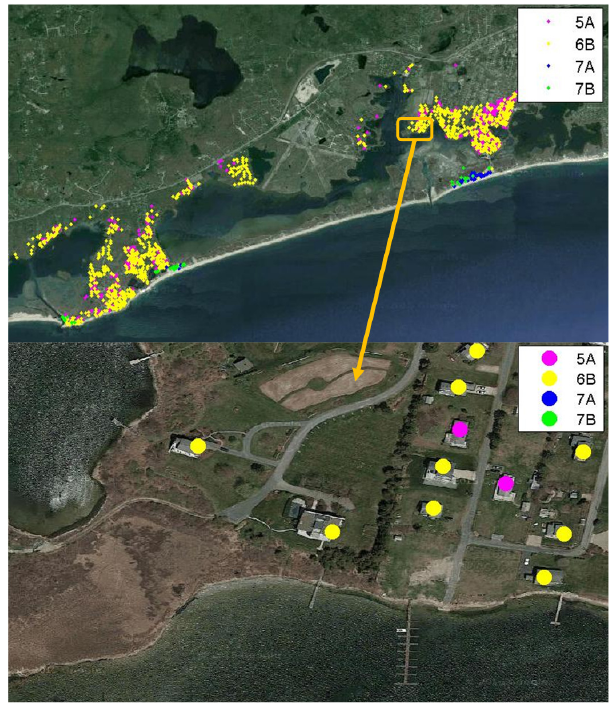
Figure 9. Location and type of structures for the Charlestown, RI study area (upper panel). The lower panel shows the ability to resolve at the structure by structure level.